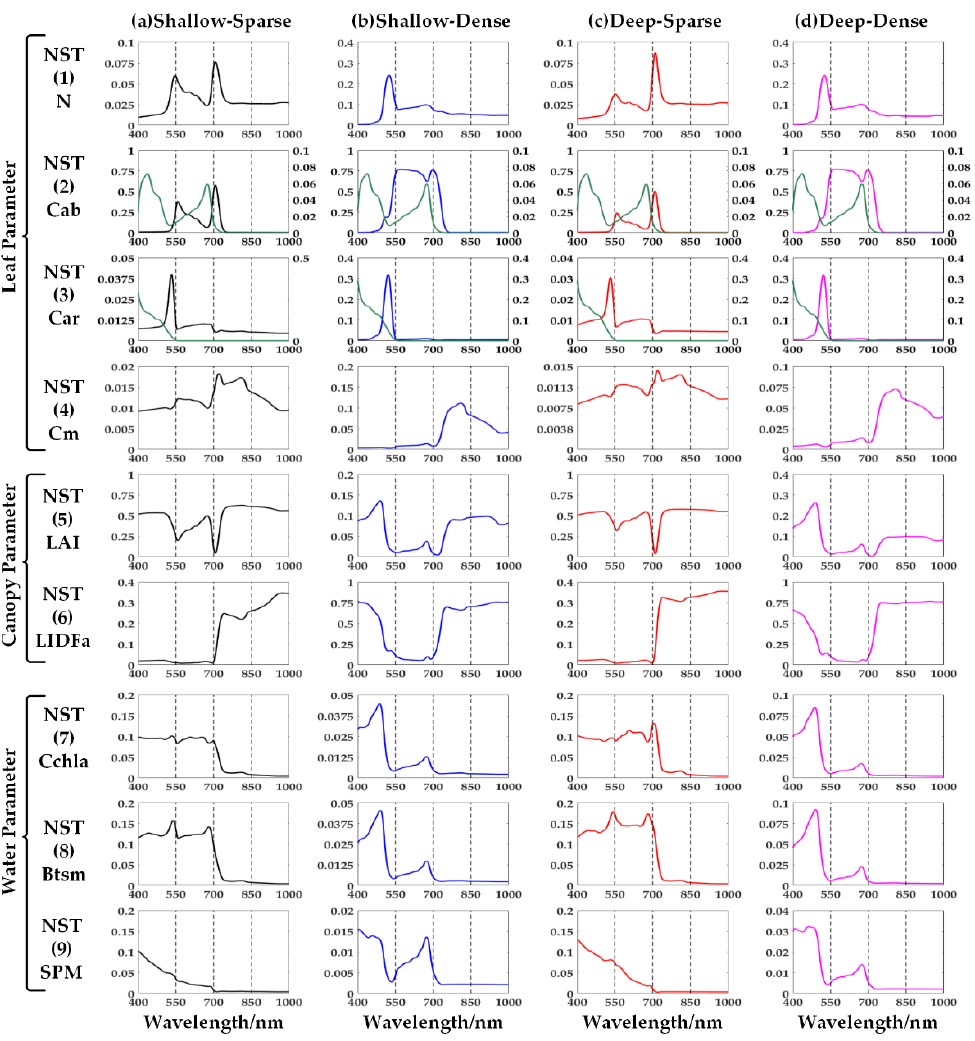
Figure 4. In four different cases, the curves of high sensitivity parameters varying with wavelength. The columns ( a ), ( b ), ( c ), ( d ) represent the case of shallow-sparse, shallow-dense, deep-sparse and deep-dense, respectively. (1)–(9) represent the high sensitivity parameters, (1): N, (2): Concentration of chlorophyll a + b (Cab), (3): Concentration of carotenoid (Car), (4): Concentration of dry matter (Cm), (5): Leaf area index (LAI), (6): Leaf inclination distribution function parameter a (LIDFa), (7): Concentration of chlorophyll a, in water (Cchla), (8): Coefficient to calculate scattering of total suspended matter (Btsm), (9): Concentration of suspended matter (SPM). It should be noted that the curves of absorption coefficient of Cab and Car are also shown in (2) and (3). The vertical axis on the right shows the range of the absorption coefficient.